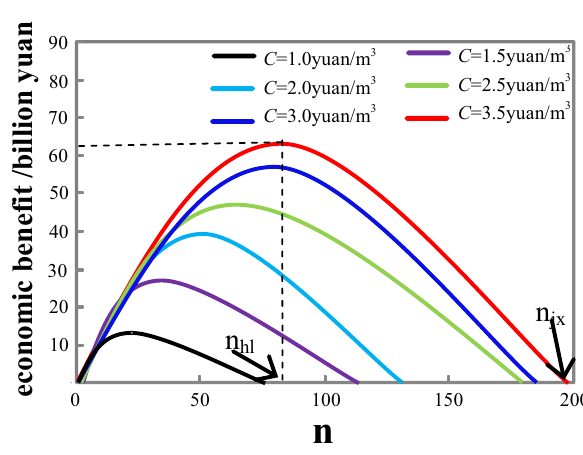
Fig. 7 The curves of cumulative production and economic benefits versus time